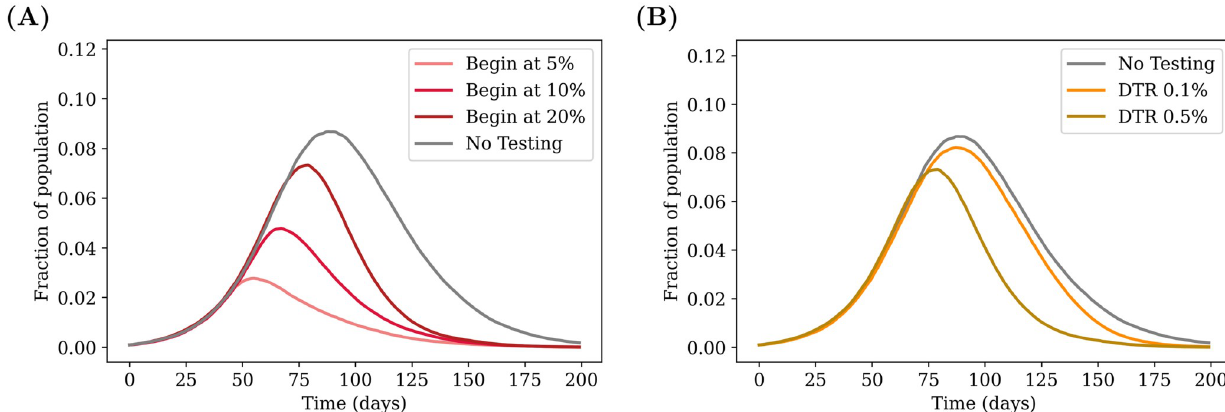
Fig 4. Effect of targeted testing. (A) Comparing the effect of delays in starting testing. The daily testing rate is fixed at 0.5% of the population per day, but testing is started at different points during the infection, depending on the number of recovered individuals present in the population. The greatest advantage is obtained when testing is started earlier. (B) Varying the daily testing rate. Testing is started when 20% of the population has recovered from the disease, and the effects of different testing rates are compared. Higher testing rates reduce the value of the peak and push it earlier in the infection. The grey curves in both cases represent the case of no testing. All tests are PCR (sensitivity and specificity of 100%) with results declared immediately (zero delay), and individuals (but not family members) are isolated when a test is declared positive (see strategy (a) in Methods). The curves are obtained after averaging over 100 simulation runs.